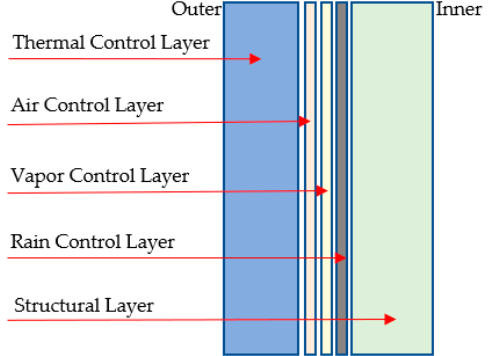
Figure 1. A schematic representation of the control layers and their positions, according to Lstiburek’s “perfect wall” concept. Externally insulated assemblies have been studied for their ability to reduce the thermal bridging that is caused by the repetition of structural elements, such as studs, in light-frame constructions and to reduce the risk of condensation inside structural cavities, specifically on the backside of the sheathing.